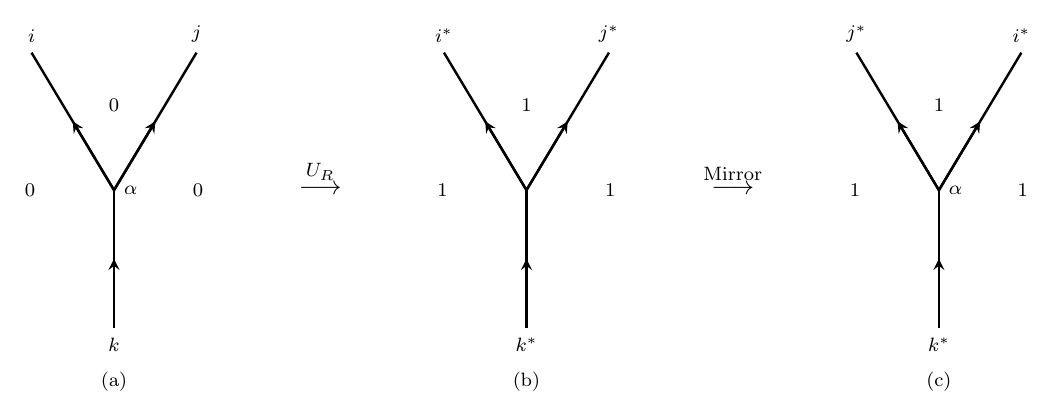
Figure 15 . The action of U R sends a graph (a) on B to a graph (b) on B 0 but in the \wrong" orientation. This means that the tensor product in graph (b) is taken from right to left. In order to get back to our convention of tensor product from left to right, we take a mirror of graph (b) and obtain graph (c). The resulting graph (c) is read in C 0 .